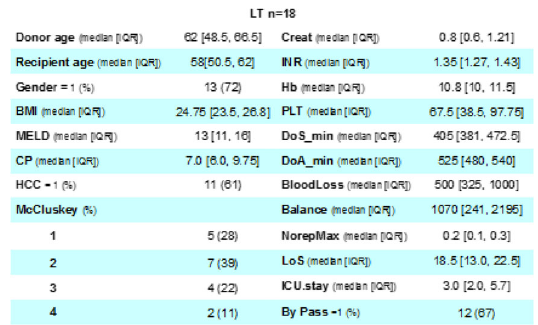
Table 1 (abstract 000728). Population characteristics T1